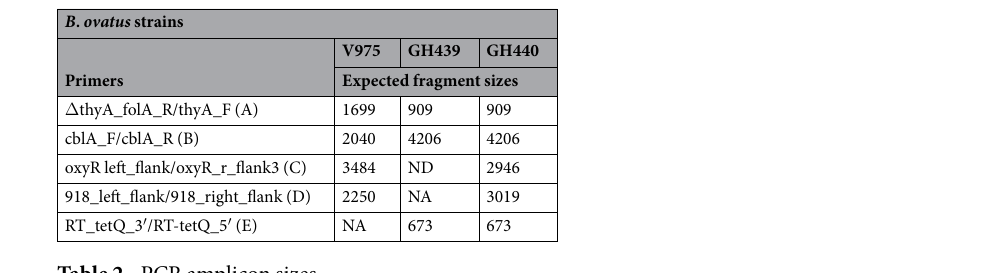
Table 2. PCR amplicon